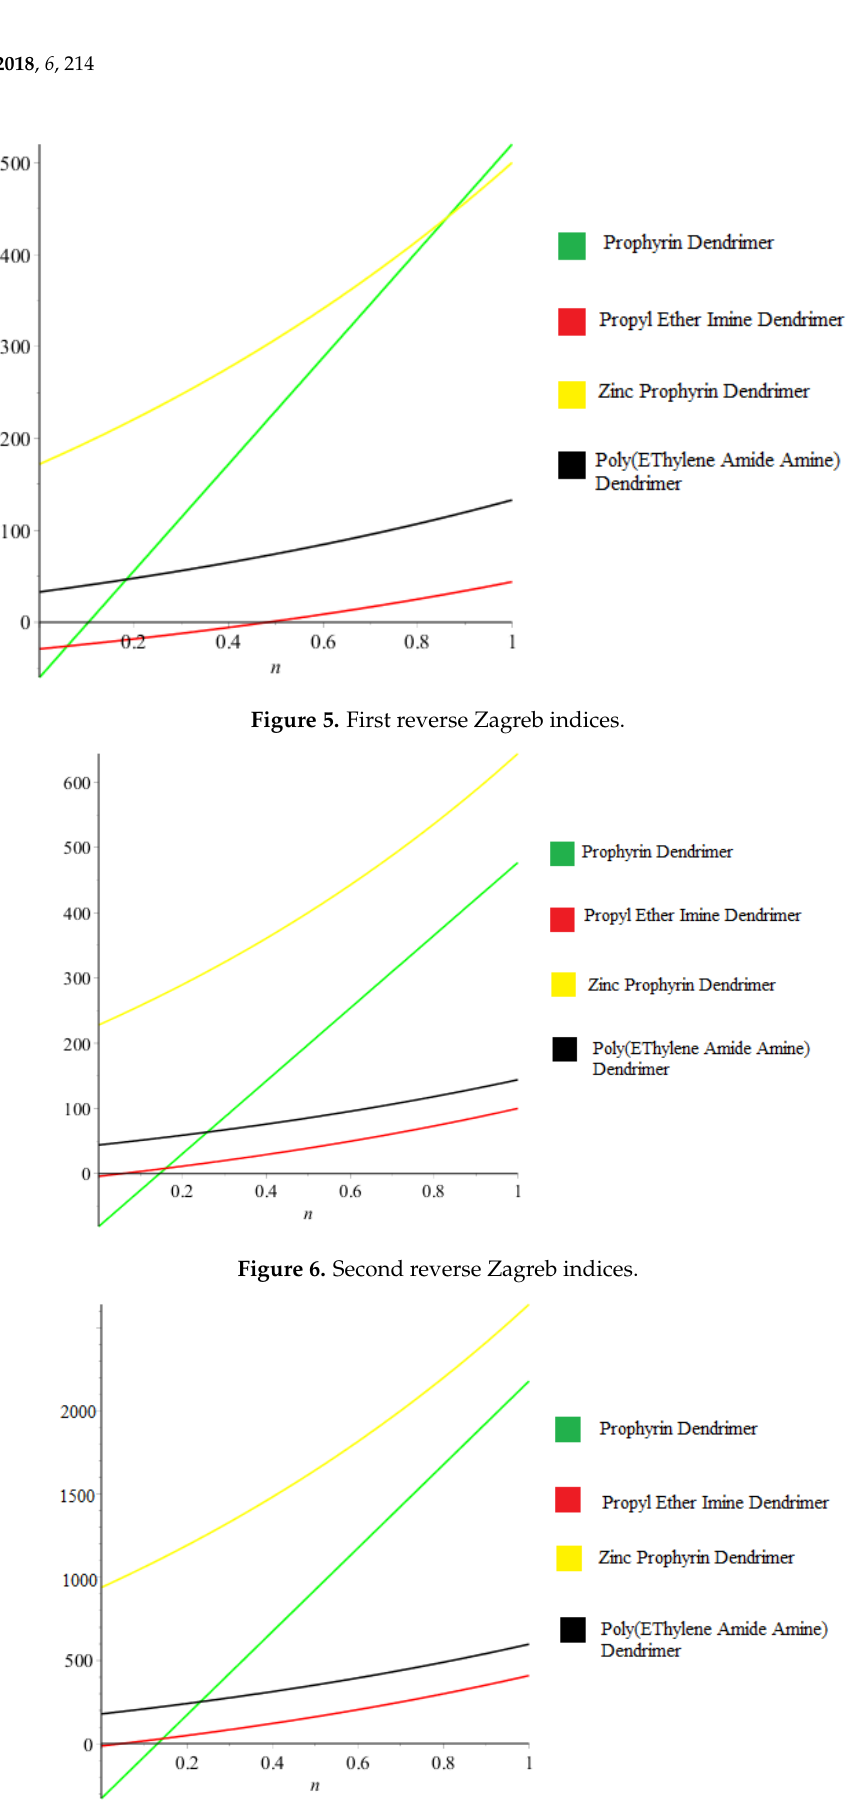
Figure 7. First reverse hyper-Zagreb